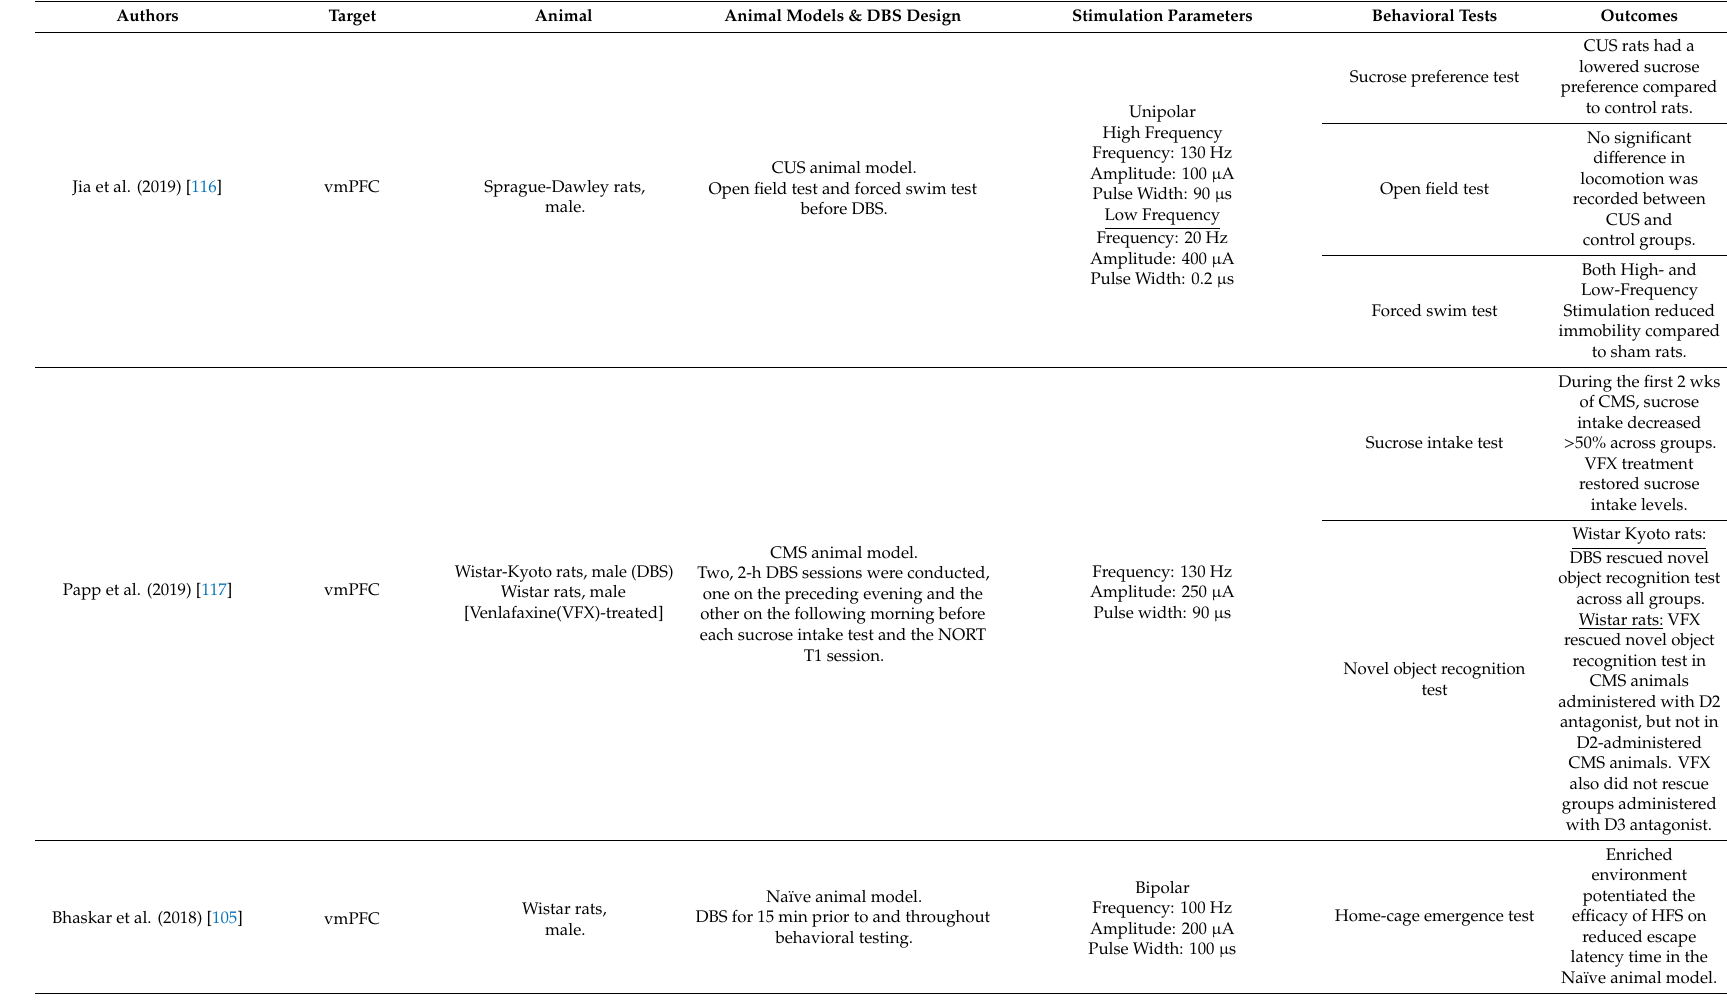
Table 3. A list of preclinical studies on deep brain stimulation of the medial prefrontal cortex in